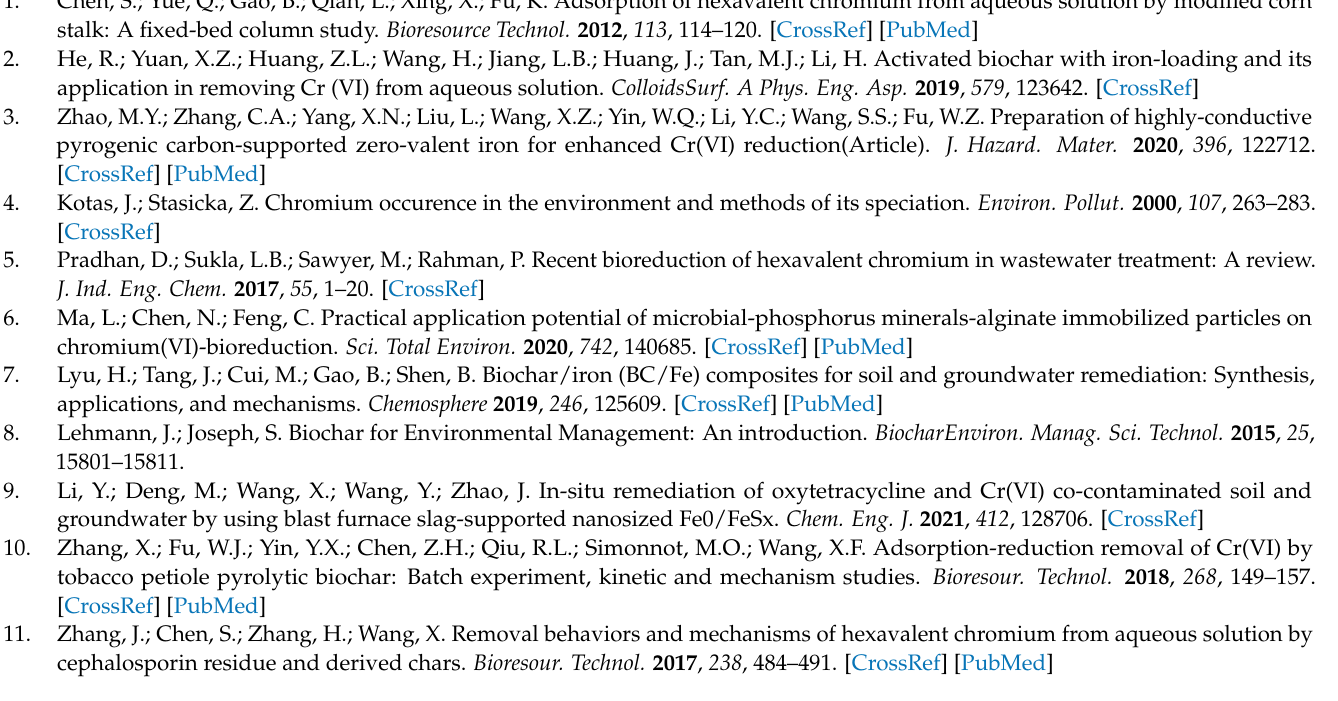
Figure S2. (N 2 adsorption-desorption isotherm for BC ( a ), FeCl 3 @BC ( b ) and Fe(NO 3 ) 3 @BC ( c )). Figure S3. (Change of zeta potential of BC, FeCl 3 @BC and Fe(NO 3 ) 3 @BC). Figure S4. (( a )The Cr species content (Cr(VI) and Cr(III), respectively) in solution and distinct elution rates (the inset), ( b ) the leaching total Fe content after elution under three eluants with different acidity and alkalinity). Figure S5. (( a ) The variance of TCr and Cr(VI) concentrations, ( b ) The variance of dissolved Fe concentration). Figure S6. (XRD spectra of before and after the reaction of FeCl 3 @BC with